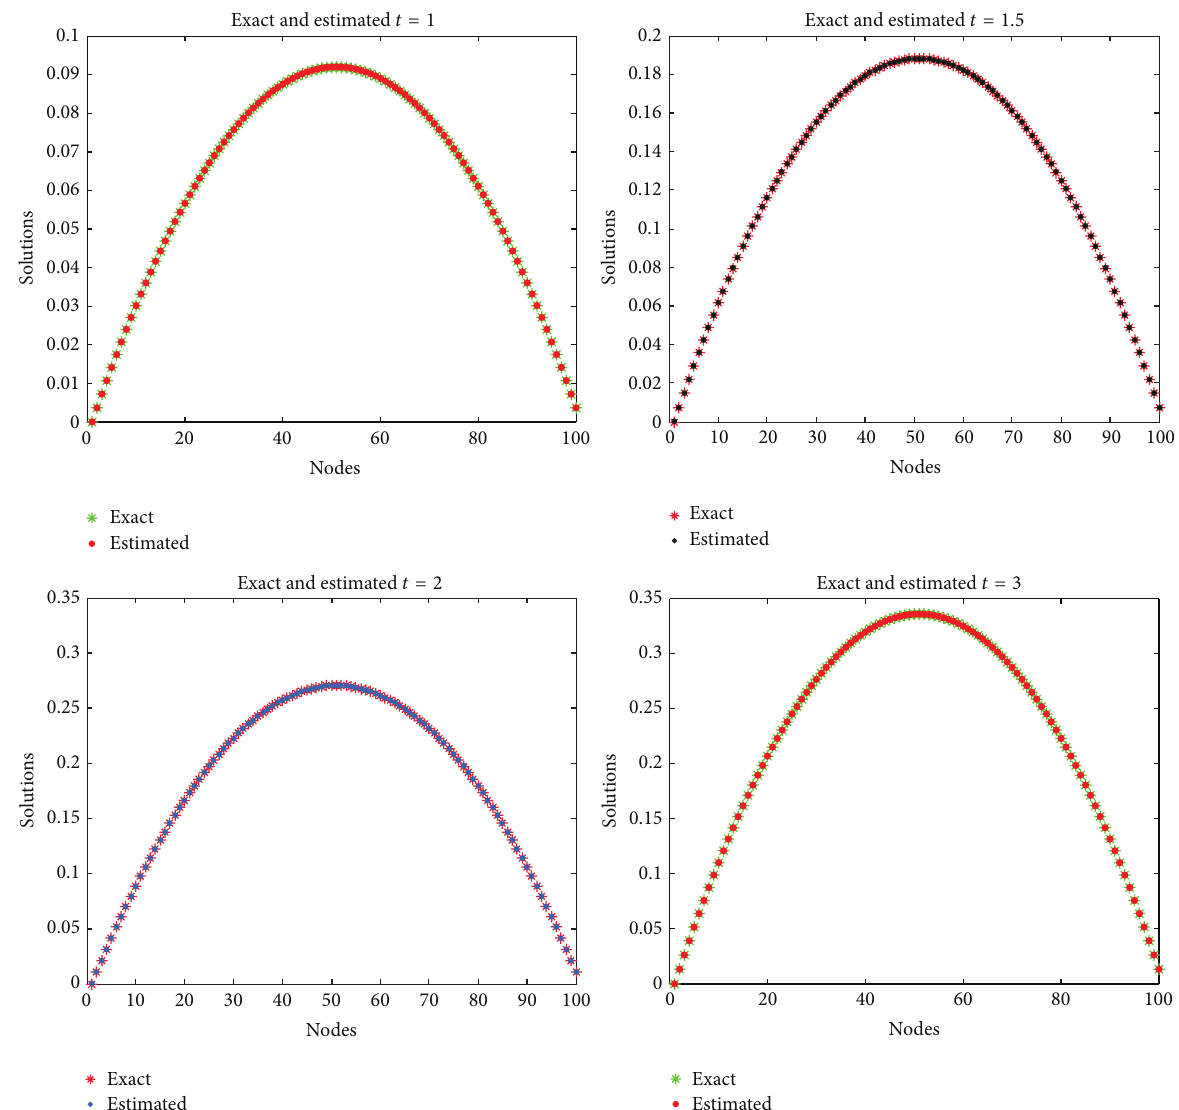
Figure 2: The numerical and analytical solutions at time 𝑡 = 1, 1.5, 2, 3 with 𝑑𝑥 = 0.01 , 𝑑𝑡 = 0.001 and using TPS (with 𝑚 = 2 ) as the radial basis function for Example 2